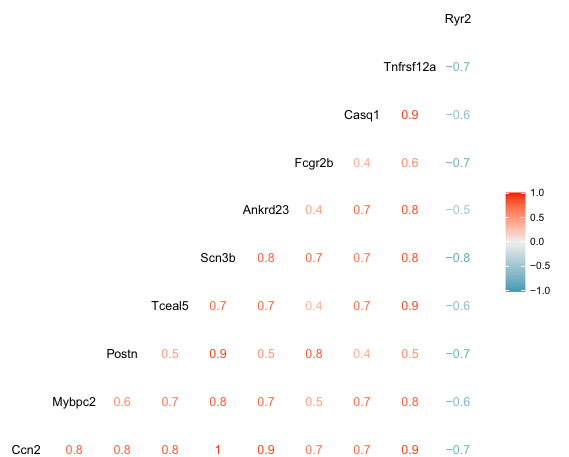
Fig. 6 Correlation analysis for the 10 core genes with the verification dataset